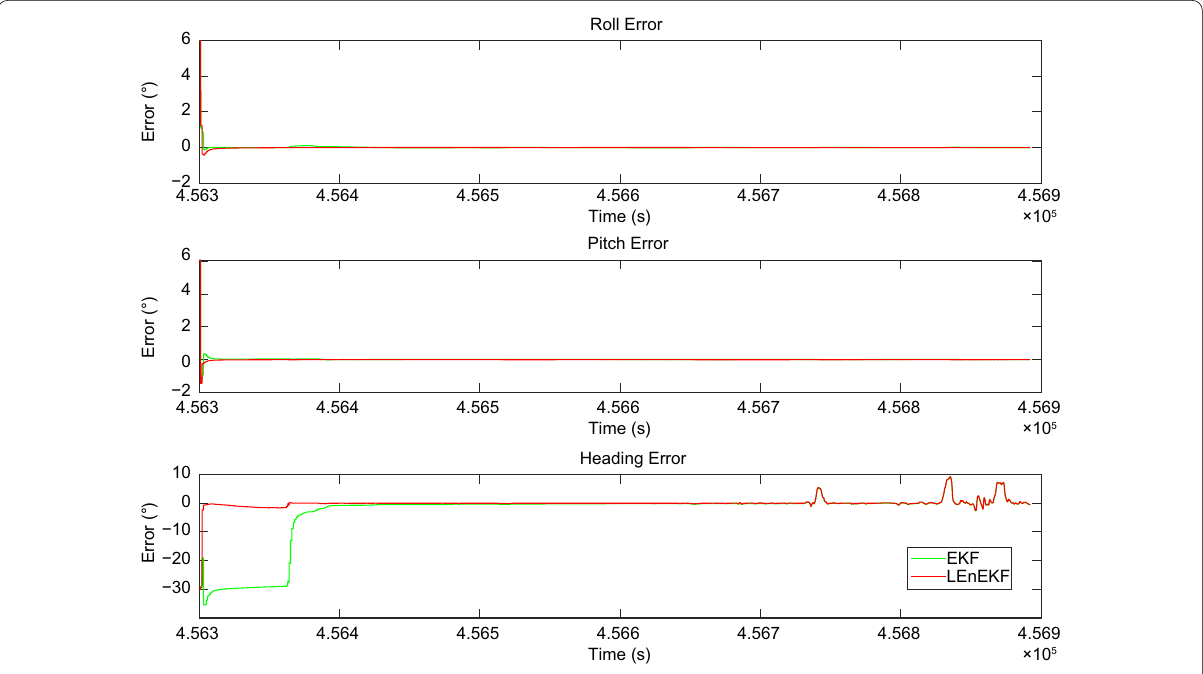
Fig. 7 Attitude errors of two 60 s GPS outages with large misalignment